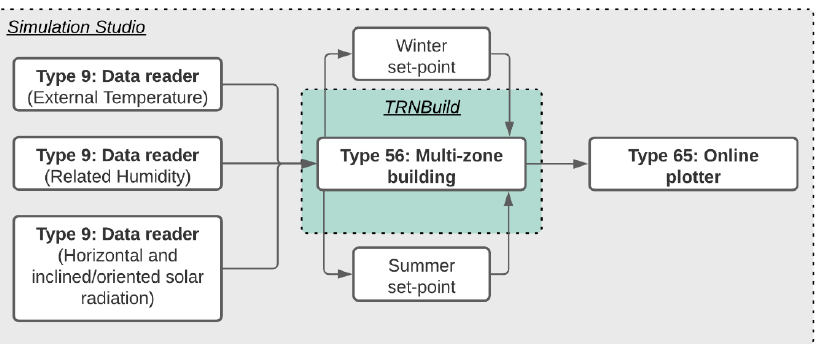
Figure 3. Model flowchart in Trnsys.